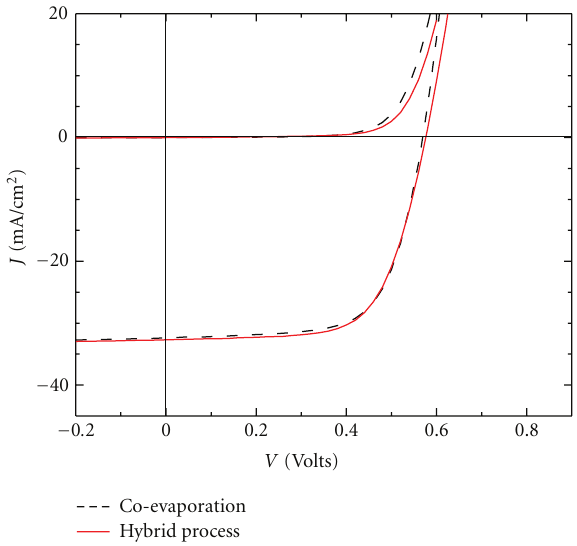
Figure 5: Current density-Voltage ( J-V ) characteristics of Cu(In,Ga)Se 2 solar cells deposited by hybrid and coevaporation